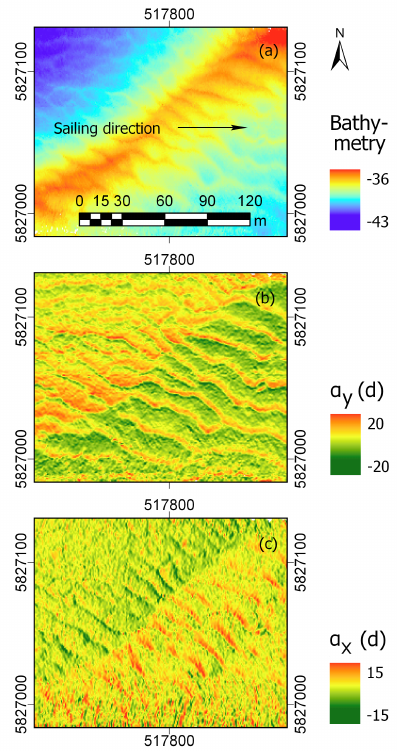
Figure 3. ( a ) Bathymetry data on a crest of a sand wave, ( b ) across track slopes α y and ( c ) along track slopes α x ; depths are given in meters, slopes are in degrees ( d